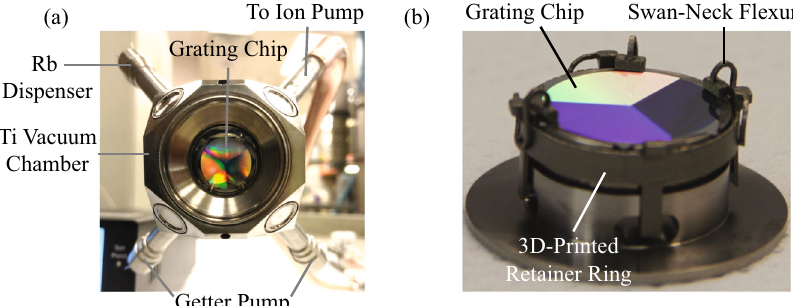
Fig. 2 Images of the custom Ti vacuum package and the in-vacuum mounted grating chip. a View of the vacuum package looking at the grating chip through the GMOT cooling beam entry window ( ≈ 19 mm clear aperture). The external dimensions of a truncated Ti cube are approximately 40.64 × 40.64 × 40.64 mm 3 . Also visible are Ti tubes which house the rubidium dispensers, getters, and a brazed connection to the Cu exhaust port. b Close-up view of the in-vacuum grating chip and mount prior to being laser-welded to the vacuum package. The grating chip is held in place with 3D- printed swan-neck fl exure mounts.